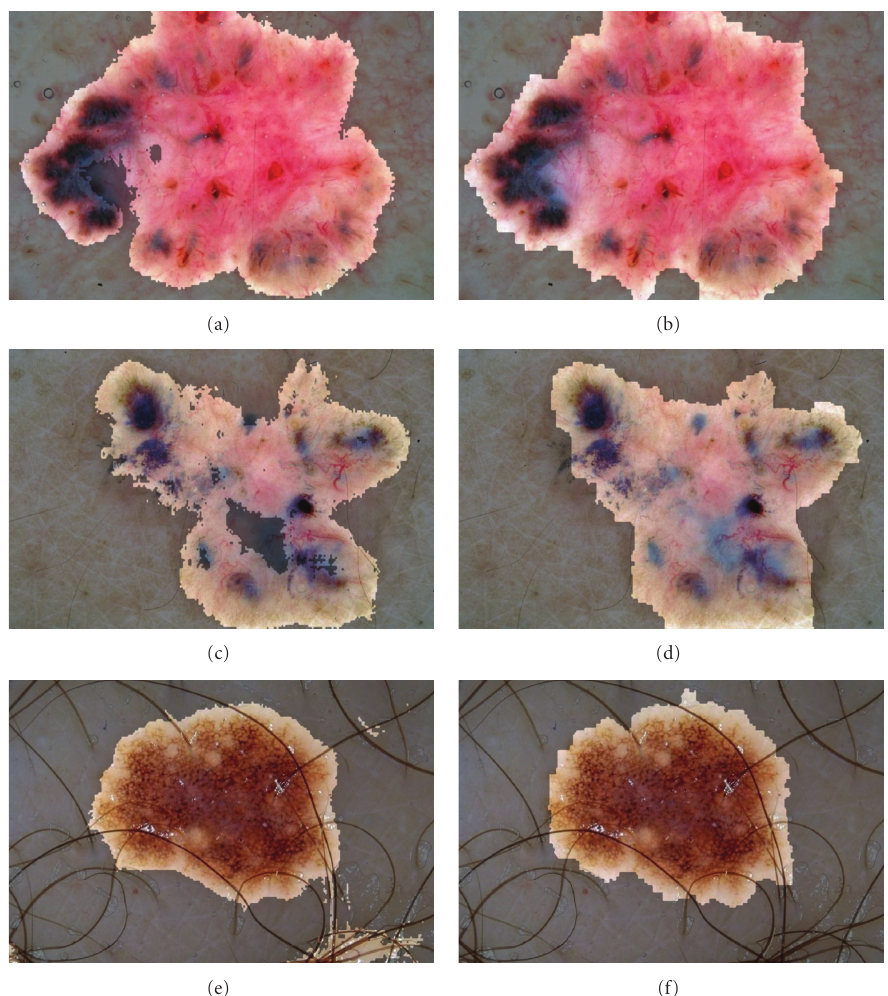
Figure 8: Comparing segmentations from our PP model (left) and CRF model (right). Since the CRF model relaxes the assumption of pixel independence in the PP model, it is able to smooth over local discontinuities. The result is better segmentations which fill in “holes” and remove